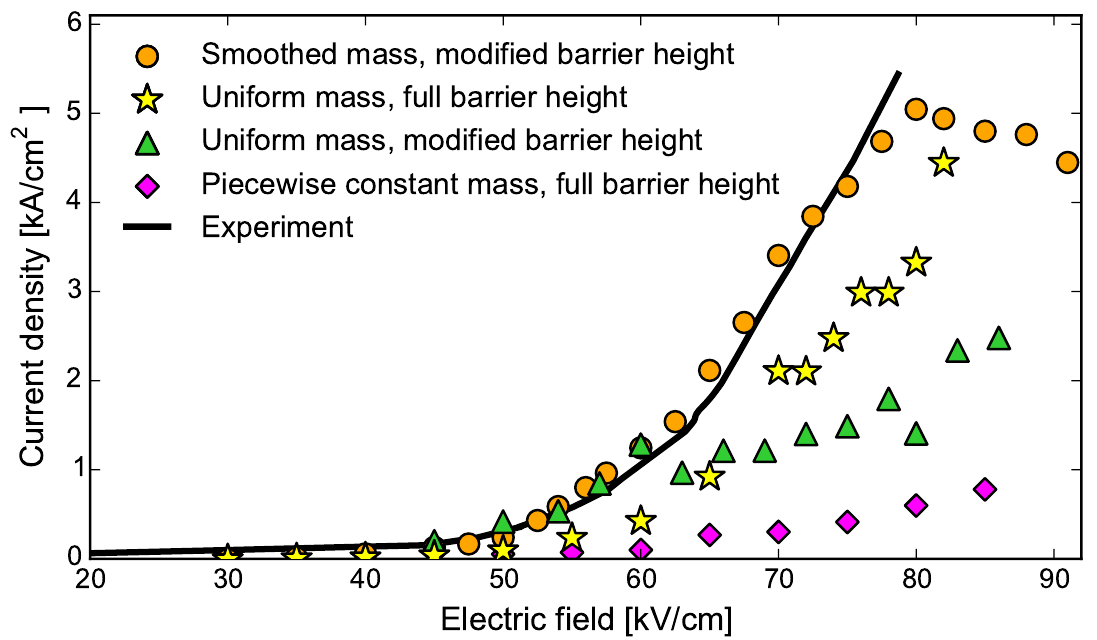
Figure 2. Current density vs. electric field for the four band structures shown in Figure